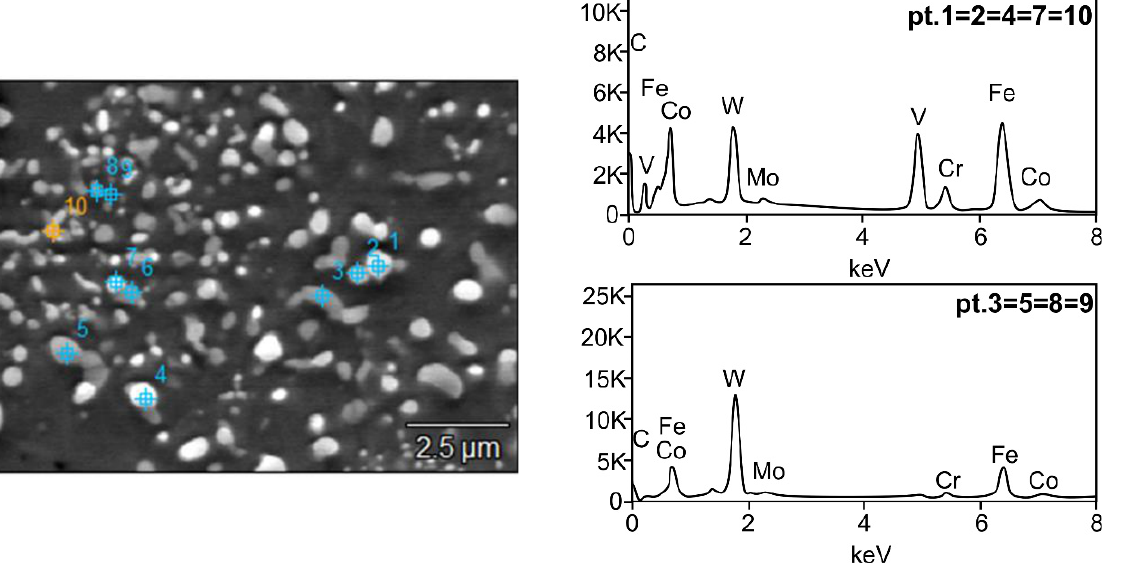
Figure 10. SEM microstructure of HSS matrix of spark plasma sintered T15 steel: 1, 2, 4, 7, 10—MC carbides, 3, 5, 6, 8, 9—M6C